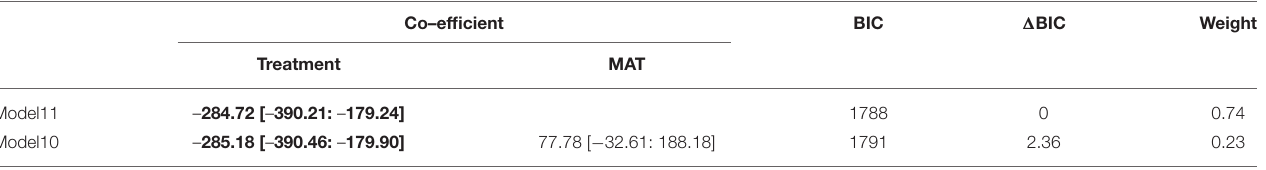
TABLE 4a | Mixed linear model outputs showing the top two models selected using BIC values for C. mopane .